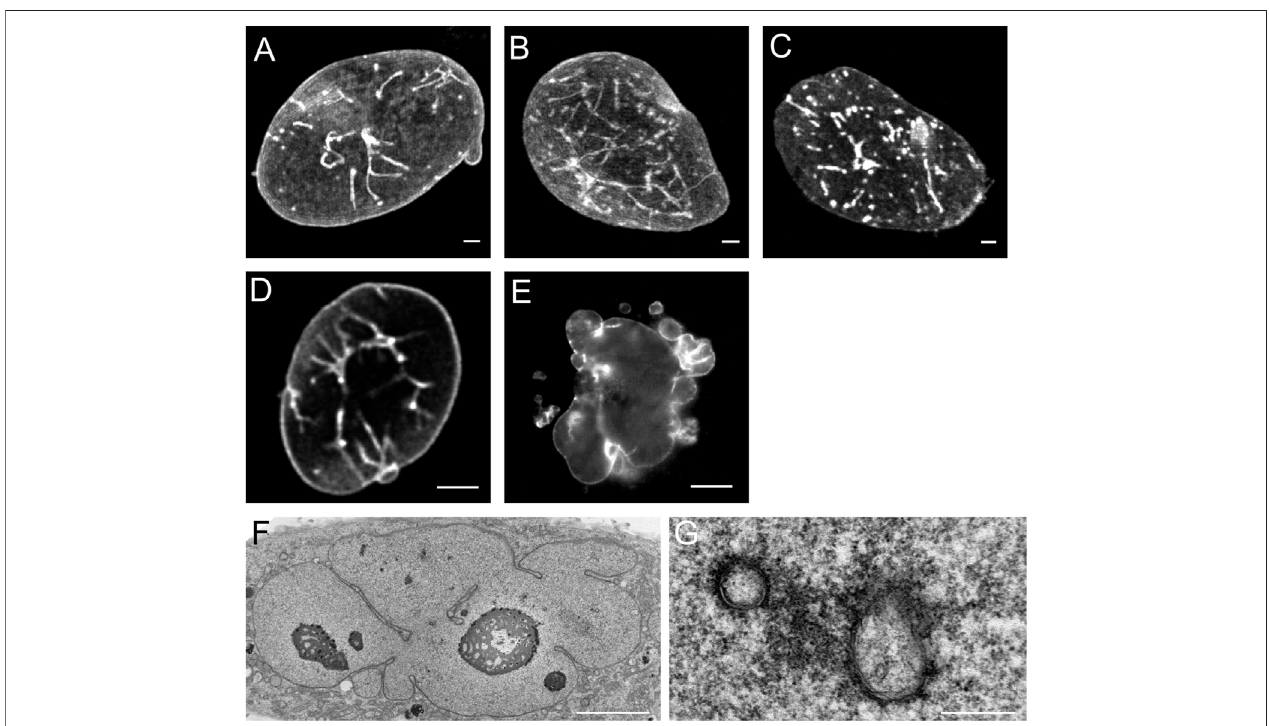
FIGURE 3 | Effects of over-expression of different types of lamins on the nucleus of CHO-cells. (A) The over-expression of lamin A leads to nuclear membrane growth and the formation of a large number of tubular invaginations of the nuclear envelope. Scale bar indicates 10 μ m. (B) The over-expression of lamin A Δ 10 leads to nuclear membrane growth and the formation of a large number of tubular invaginations of the nuclear envelope. Scale bar indicates 10 μ m. (C) The over-expression of laminCleadstomainlyaggregatesinthenucleoplasm.Scalebarindicates10 μ m. (D) Theover-expressionoflaminB1leadstonuclearmembrane growthandthe formation of a limited number of tubular invaginations of the nuclear envelope. Scale bar indicates 10 μ m. (E) The over-expression of lamin B2 leads to enlarged nuclei with highly folded nuclear membranes and lobulations of the nuclear membrane. Scale bar indicates 10 μ m. (F) EM-recording of tubular invaginations in lamin A over- expressingCHO cells. Scale bar indicates 5 μ m. (G) Detailed recording oftubularinvaginations in lamin A over-expressingCHO cells. Scale bar indicates 0.5 μ m. CHO- cells were grown, transfected and imaged as described (Broers et al., 1999). Confocal fl uorescence images (A-E) show maximal Z-stack projections.